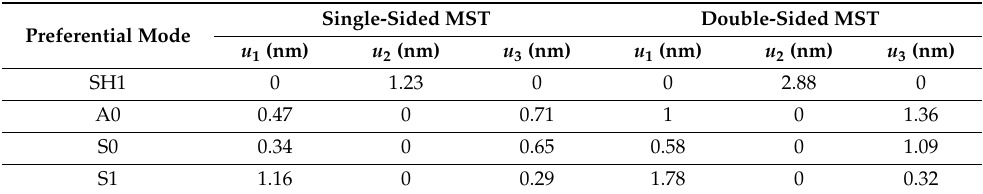
Figure 11. u 2 displacement fields at 60 ms for ( a ) single-sided MST at 563 kHz, ( b ) double-sided MST at 563 kHz out-of- phase, ( c ) double-sided MST at 719 kHz in-phase, ( d ) double-sided MST at 922 kHz out-of-phase. The plots are stretched vertically for clarity. Table 3. Comparison of displacements on the bottom surface of the plate for single-sided and double-sided MSTs. Preferential Mode